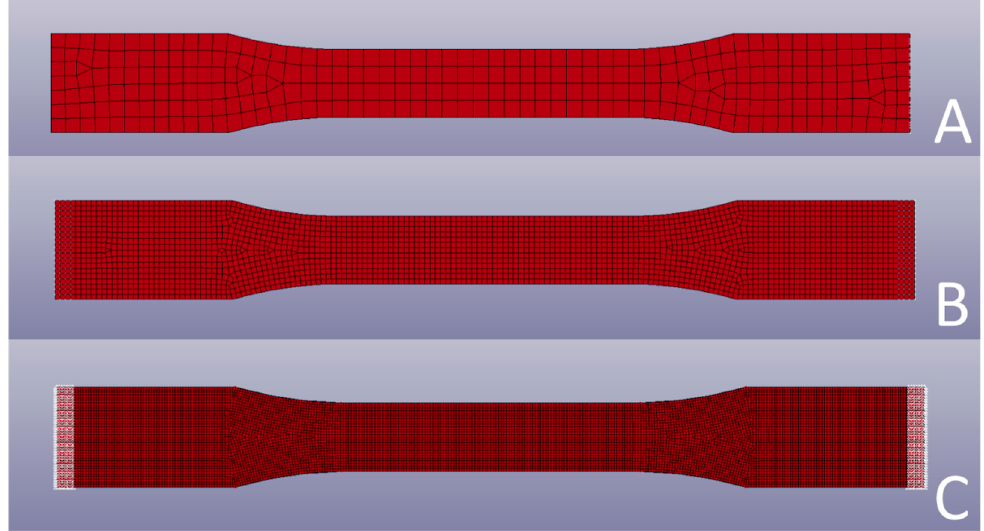
Figure 12. ( A ) Rough Mesh; ( B ) Model Mesh; ( C ) Fine Mesh.